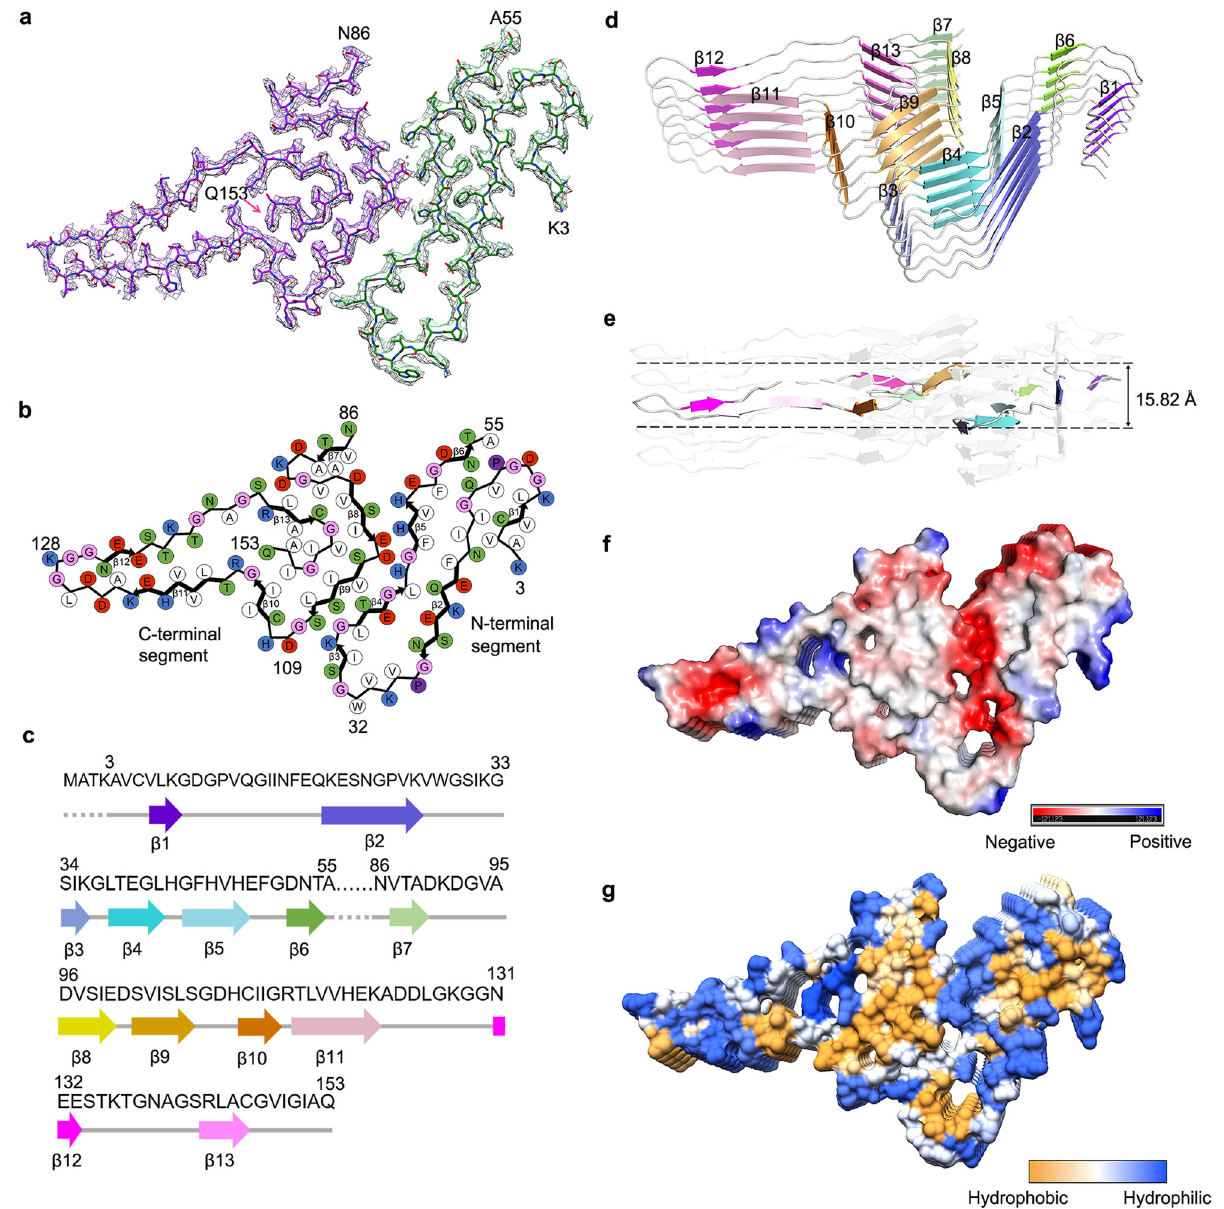
Fig. 2 Atomic structure of SOD1 fi bril. a Cryo-EM map of an amyloid fi bril from recombinant, full-length apo human SOD1 with the atomic model overlaid. The SOD1 fi bril core comprises the N-terminal segment (residues 3 – 55) and the C-terminal segment (residues 86 to 153) colored green and purple, respectively, with an internal disordered segment. b Schematic view of the SOD1 fi bril core. Residues are colored as follows: white, hydrophobic; green, polar; red and blue, negatively and positively charged, respectively; and magenta, glycine. β strands are indicated with bold lines. Side chains of most hydrophobic residues are located in the interior of the SOD1 fi bril fold. c Sequence of the fi bril core comprising residues 3 – 55 and 86 – 153 from full-length human SOD1 (1 to 153) with the observed six β strands colored violet ( β 1), blue ( β 2), light blue ( β 3), cyan ( β 4), light cyan ( β 5), and green ( β 6) in the N-terminal region and the observed seven β strands colored light green ( β 7), yellow ( β 8), gold ( β 9), orange ( β 10), pink ( β 11), magenta ( β 12), and light magenta ( β 13) in the C-terminal region. The dotted lines correspond to residues 1 – 2 and residues 56 – 85 not modeled in the cryo-EM density. d Ribbon representation of the structure of an SOD1 fi bril core containing fi ve molecular layers and two segments. e As in d , but viewed perpendicular to the helical axis, revealing that the height of one layer along the helical axis is 15.82 Å. f Electrostatic surface representation of the structure of an SOD1 fi bril core containing fi ve molecular layers and two segments. g Hydrophobic surface representation of the structure of an SOD1 fi bril core as in d . f , g Three pairs of amino acids (Lys36 and Asp109; His43 and Asp101; and His46 and Glu100) form three salt bridges at the intramolecular interface between the N- and C-terminal regions of SOD1 fi bril. The surface of two regions of the SOD1 fi bril core is shown according to the electrostatic properties (red, negatively charged; blue, positively charged) ( f ) or the hydrophobicity (yellow, hydrophobic; blue, hydrophilic) ( g ) of the residues.